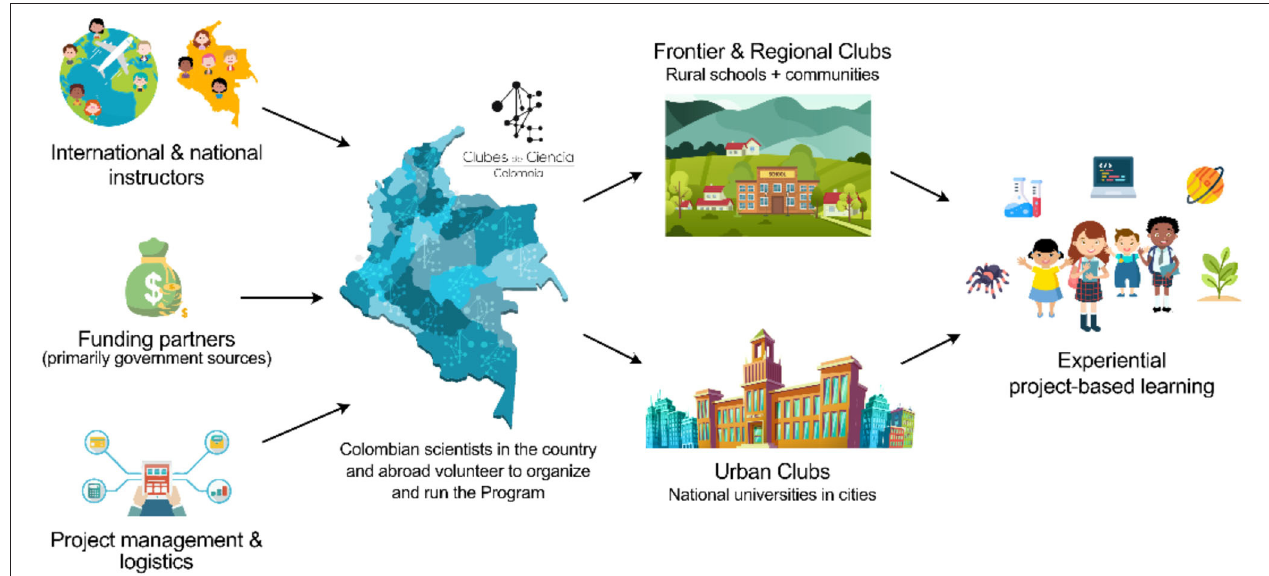
FIGURE 1 | Structure of the Science Clubs Colombia (SCC) program. The SCC program is a synergy between Colombian scientist living in the country and abroad, international and national instructors, funding agencies, a logistic team, and several other stakeholders that come together to deliver the different science clubs in both rural and urban areas of the